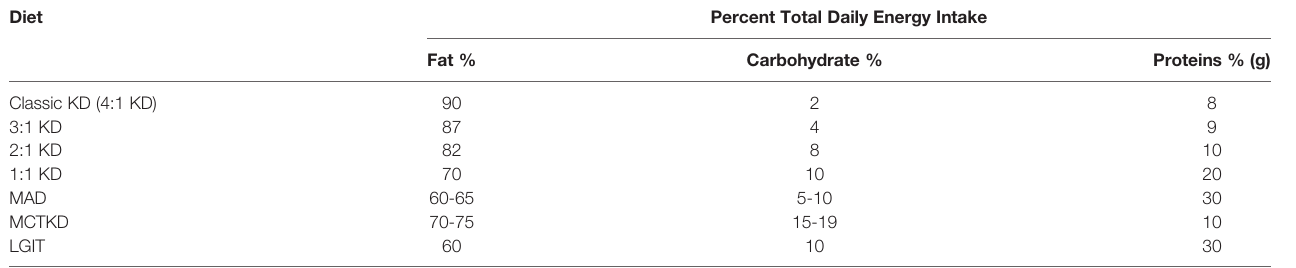
TABLE 1 | Formulations of common ketogenic diets (KDs).